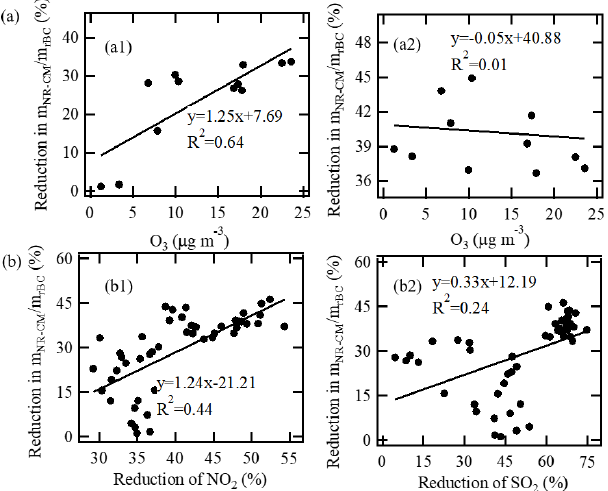
Figure 5. (a) Correlation between the reduction in the m NR − CM /m rBC ratio of BC-containing particles for the pol- lution episode during APEC relative to those (a1) before and (a2) after APEC and the daytime (07:00–19:00) O 3 concentration during APEC. (b) Correlation between the reduction in m NR − CM /m rBC during APEC relative to those before and after APEC and the corresponding reduction in the concentrations of (b1) NO 2 and (b2) SO 2